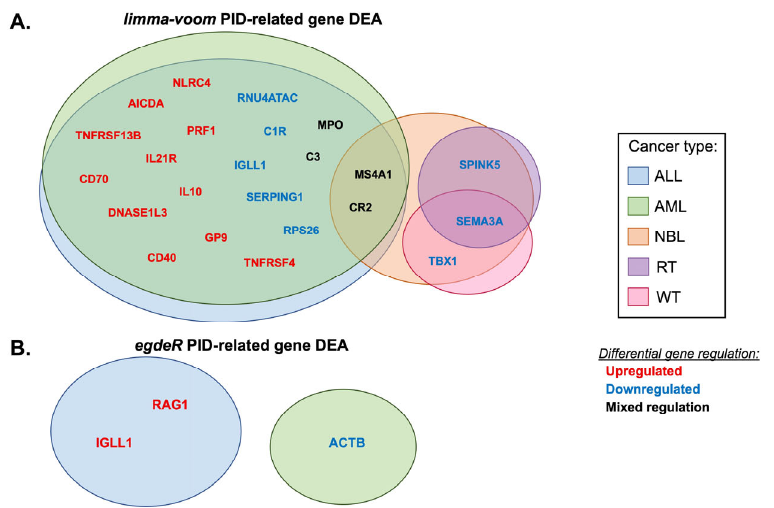
Figure 2. Venn diagram summary of DEA results of PID-related genes that are significantly differentially expressed in pediatric cancer types including AML, ALL, WT, RT, and NBL. Differentially expressed genes in each cancer type are listed (red: upregulated, blue: downregulated, or black: if the gene had mixed regulation in different cancer types. The analyses have been performed using the TCGAbiolinks R package and the ( A ) limma-voom pipeline, or ( B ) edgeR